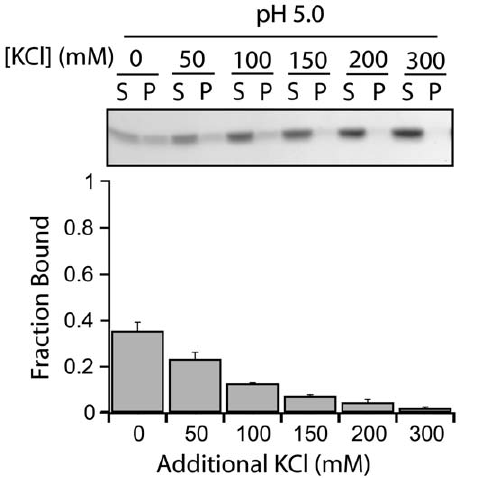
Figure 3. Fis1 D TM membrane binding is salt dependent. A vesicle sedimentation assay was used to measure the fraction of Fis1 D TM bound to lipid vesicles as a function of increasing ionic strength. Panel depicted as in Figure 1 with experiments done in a similar manner with 5 m M protein incubated for 6 hours at 25 u C with 100 m M of 100 nm lipid vesicles (1:20 protein:lipid). Average fraction bound and the standard error of the mean were calculated from n=2 independent measurements.